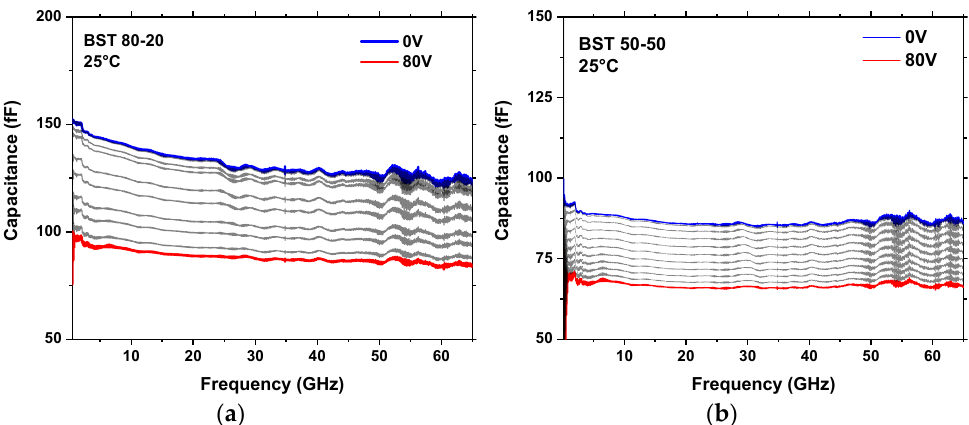
Figure 2. Frequency evolution of IDC device capacitances for different applied direct current (DC) bias voltages for the ferroelectric composition Ba x Sr 1-x TiO 3 (BST) 80–20 ( a ) and BST 50–50 ( b ). From the data of Figure 2 the tunability curves 𝐶 = 𝑓(𝑉) (capacitance variation with the applied bias voltage) can be extracted. They are shown for IDC capacitances at 30 GHz at different device temperatures between 25 °C and 75 °C for the case of BST 80–20 and BST 50–50 in Figure 3a,b, respectively. For both type of devices it can be noted that there is almost no remanent polarization effect (closed butterfly loops). The temperature evolu- tion of the BST80 – 20 composition is less than 5%, which has already been reported for BST at lower frequencies [26]. The BST 50–50 dielectric properties naturally depend on the temperature as the composition is situated near to the phase transition to the paraelectric phase, and the material’s permittivity and hence the capacitance is decreasing as the tem- perature increases. In order to better visualize and compare the capacitance evolution with temperature, we plotted in Figure 3c the temperature dependence of the extracted capacitance at 30 GHz and 0 V applied bias for the two devices. The errors associated to the extraction of the capacitance values from the measurements (measurement reproduc- ibility) were estimated to be less than 2%. The curve corresponding to the BST 50–50 com- position confirm thus its paraelectric behavior (decrease of the permittivity and capaci- tance with temperature), while the capacitance evolution for the BST 80–20 device shows a rather ferroelectric behavior, with a Curie temperature situated around 55–65 °C. Alt- hough the temperature-dependent measurements should be enlarged to a wider temper- ature range in order to fully assess the ferroelectric/ paralectric behaviour of the films, our preliminary results offer already useful insight towards the implementation of the two compositions in functional RF devices operating in the millimeter-waves domain. The tunability of a capacitor is an important parameter defining its ability to effi- ciently tune the capacitance and is determined using Equation (4): 𝑇(%) = (cid:3436)𝐶(𝑉 (cid:3040)(cid:3036)(cid:3041) ) − 𝐶(𝑉 (cid:3040)(cid:3028)(cid:3051) ) 𝐶(𝑉 (cid:3040)(cid:3036)(cid:3041) )